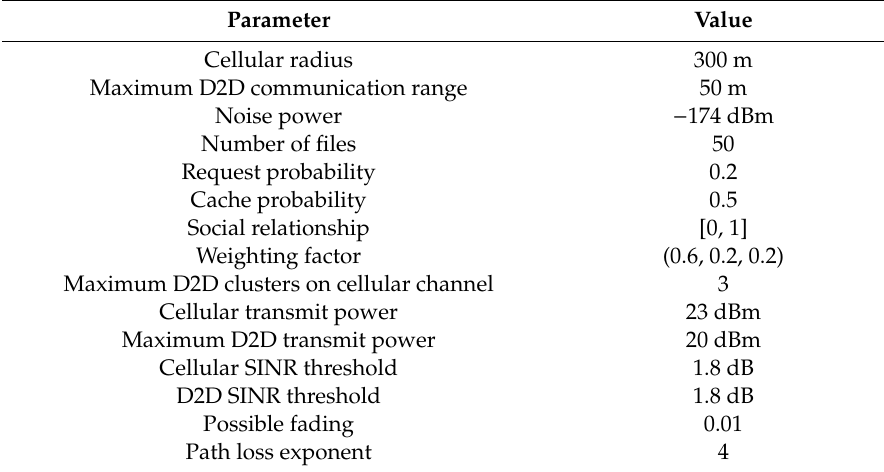
Table 1. Simulation